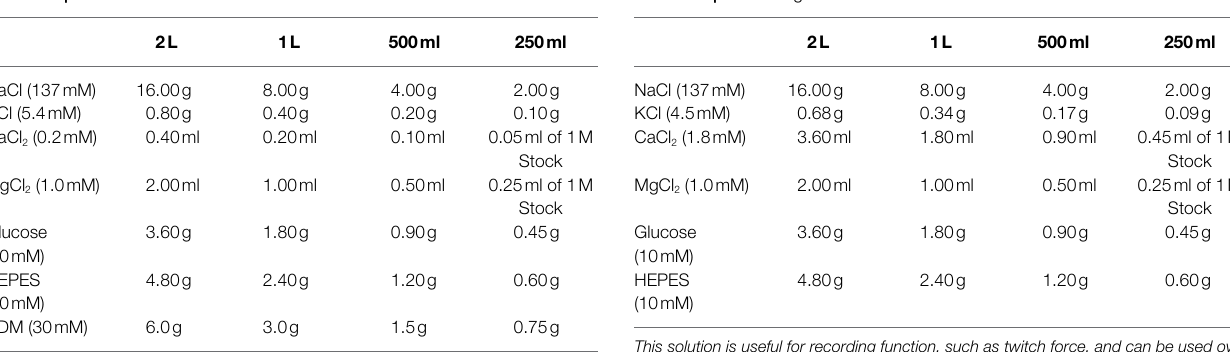
TABLE 2 | Recording solution.